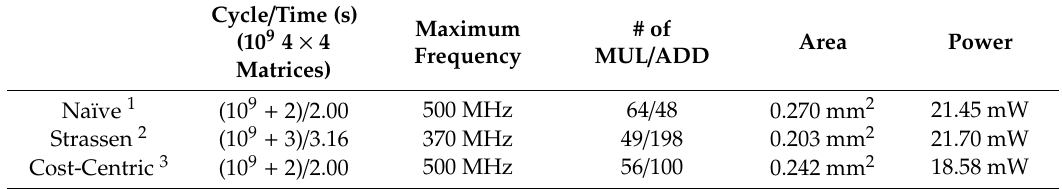
Table 3. Performance of the 4 × 4 pipelined matrix multiplication (16 bit MUL ( M ), 32 bit ADD ( A )). Cycle / Time